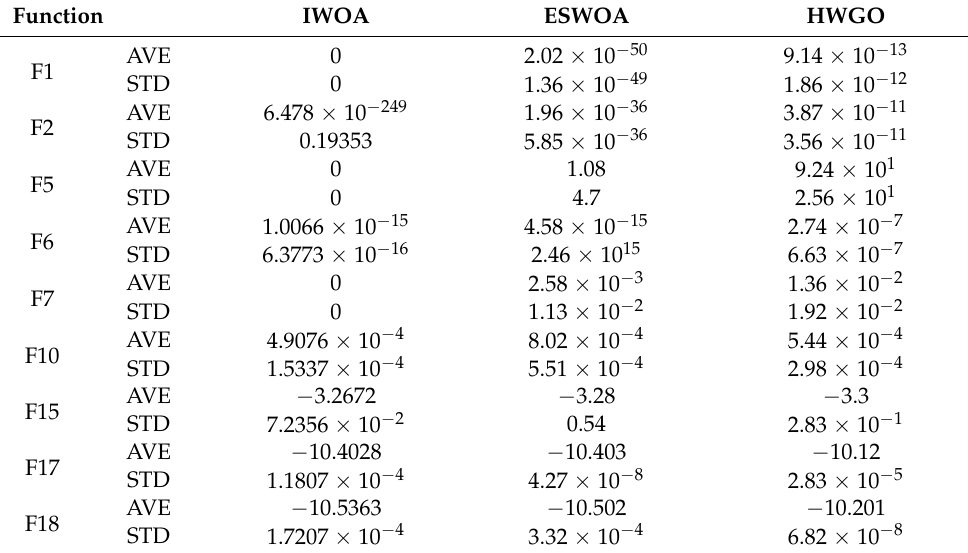
Table 5. Performance comparison for IWOA and other improved WOAs.